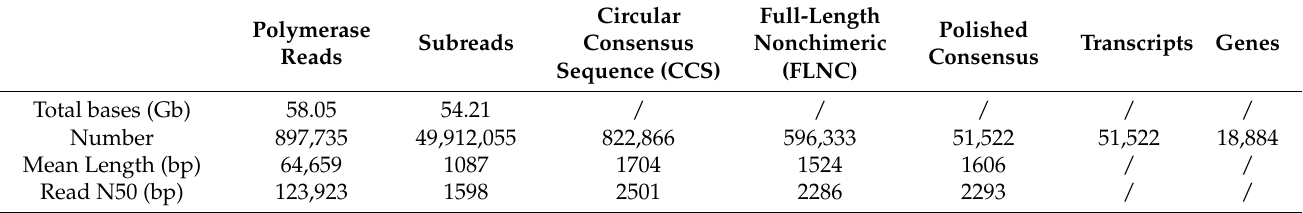
Table 2. Full length RNA-seq